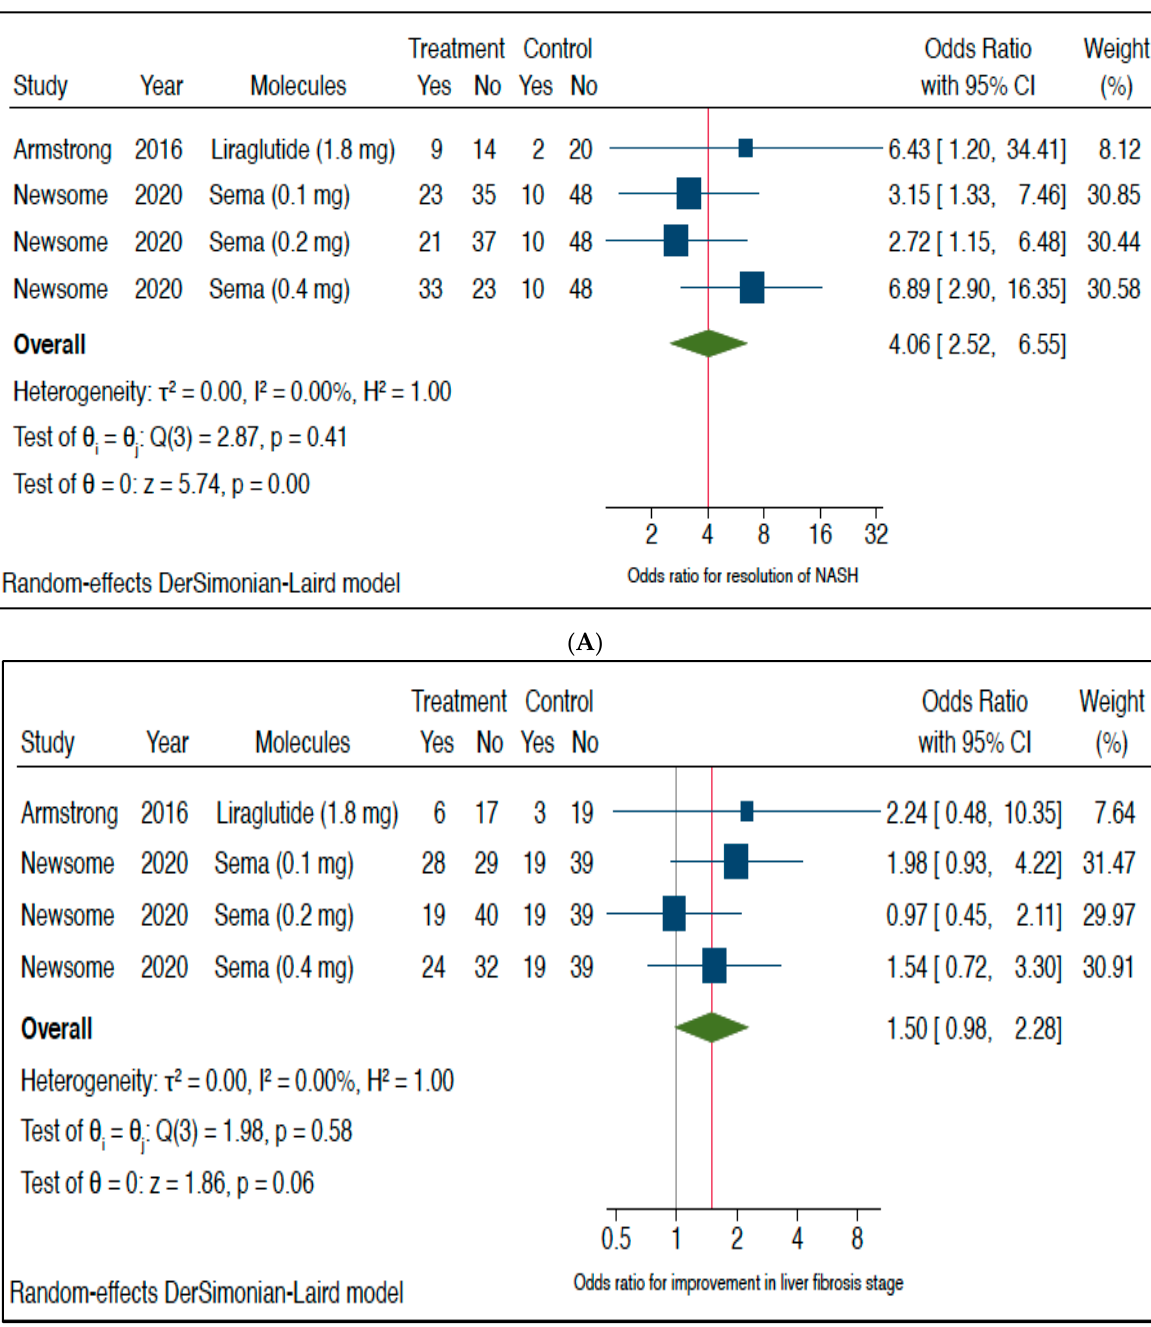
Figure 3. Forest plot and pooled estimates of the effect of GLP-1 RAs ( n = 2 RCTs included using either liraglutide 1.8 mg/day or semaglutide at a dose of 0.1 mg, 0.2 mg or 0.4 mg/day subcutaneously) on histologic resolution of NASH with no worsening of liver fibrosis (panel A ), and improvement in liver fibrosis stage without worsening of NASH (panel B ) as compared with placebo. The pooled (green diamond) and individual effect sizes for all RCTs included were expressed as random-effect odds ratio (OR) and 95% confidence intervals (CI).